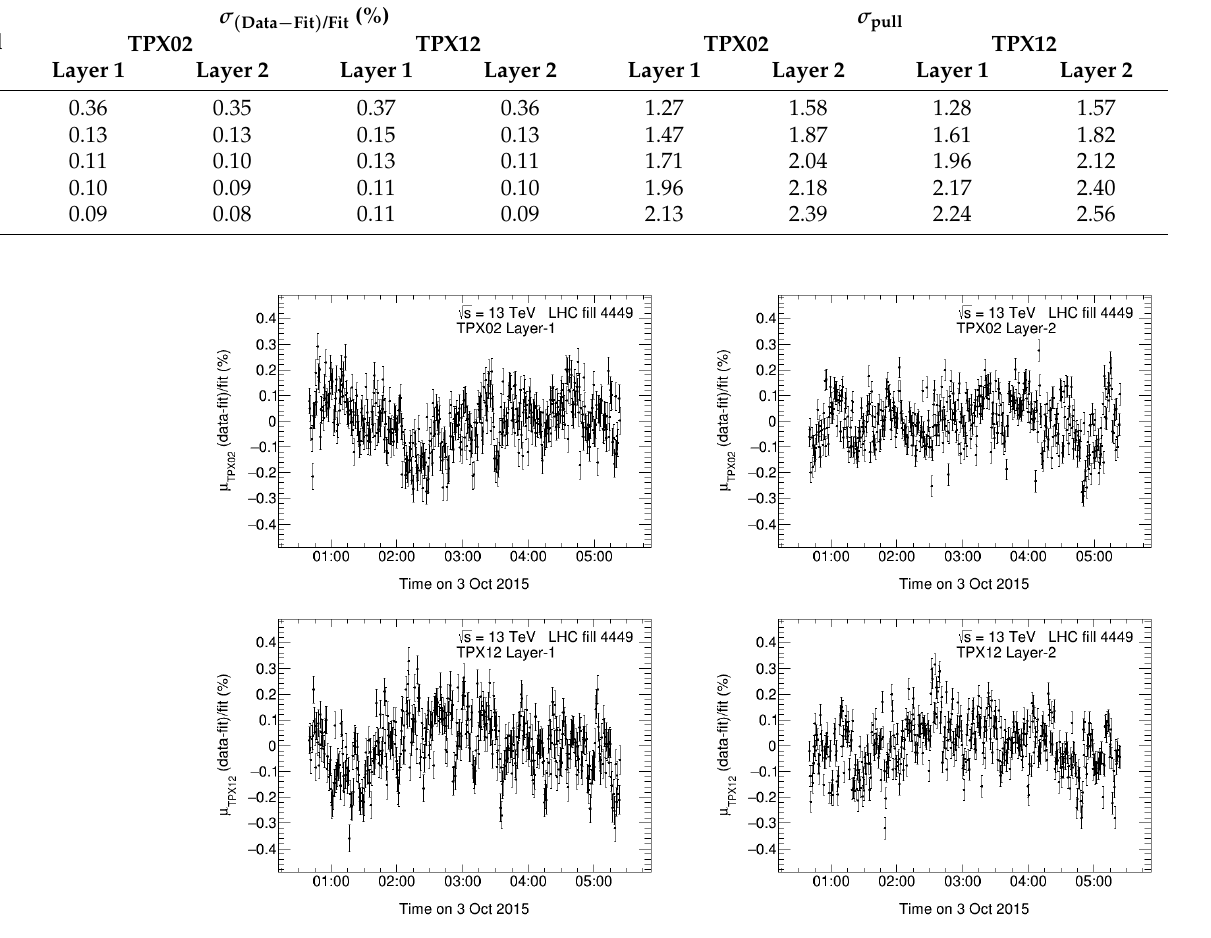
Figure 37. Relative difference between the data and the fitted average number of interactions per bunch crossing as a function of time, seen by TPX02 and TPX12 for layers 1 and 2. The data are shown for 30 frames (1s each) combined in order to decrease the statistical uncertainty. LHC fill 4449. Taken from Ref.